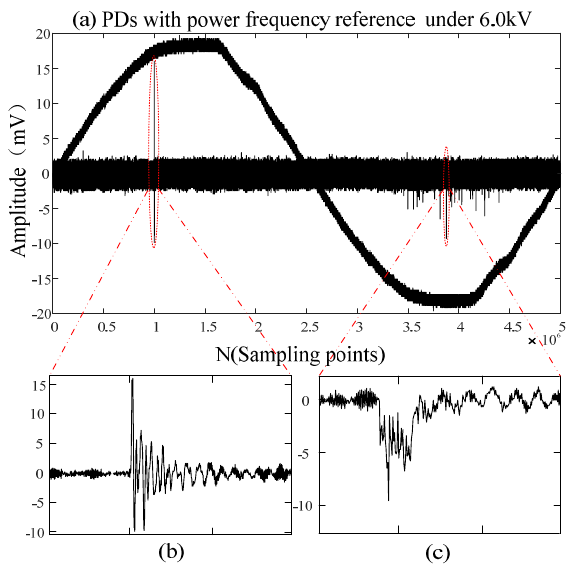
Figure 16. ( a ) PDs with frequency reference under 6.0 kV; ( b ) The enlarged view of PDs occurring in the positive half-period; ( c ) The enlarged view of PDs occurring in the negative